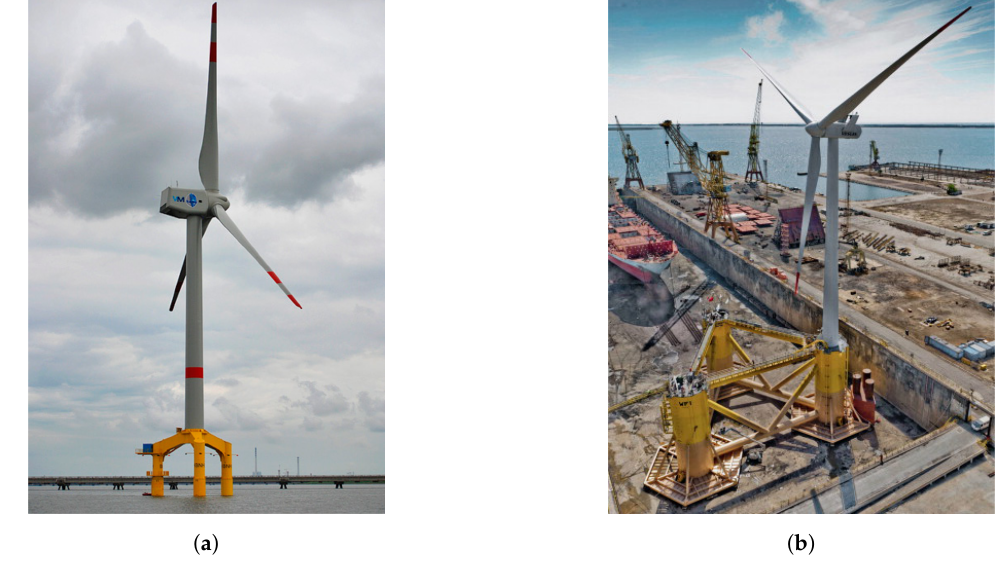
Figure 1. Offshore wind turbines. ( a ) Wind turbine over a fixed foundation [14]. ( b ) Floating offshore wind turbine assembly